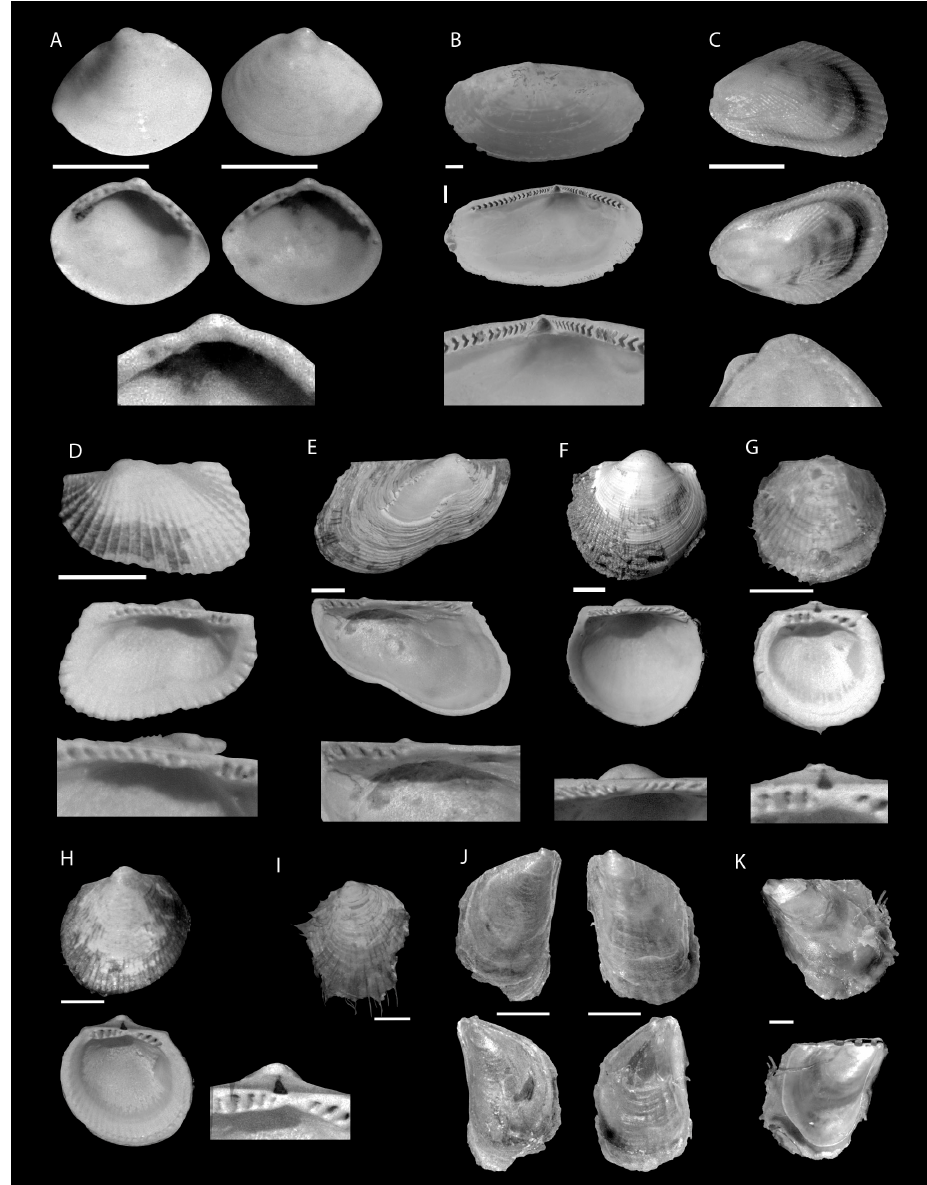
Figure 3. ( A ) Tindaria sp.; ( B ) Orthoyoldia solenoides ; ( C ) Brachidontes sp.; ( D ) Anadara secticostata ; ( E ) Bentharca asperula ; ( F ) Bathyarca glomerula ; ( G ) Limopsis cristata ; ( H ) Limopsis sulcata ; ( I ). Limopsis sp.; ( J , K ) Isognomon bicolor . Scale bars = 1